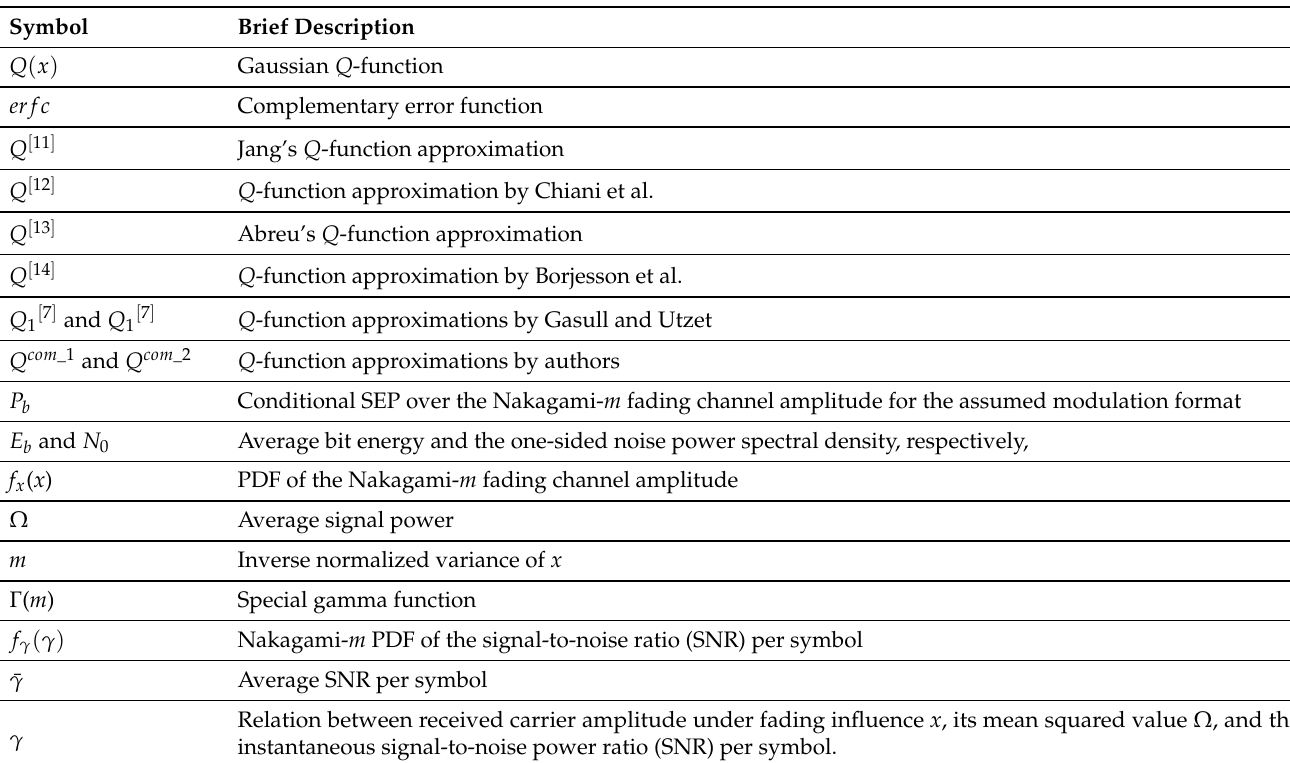
Table 1. Table of important symbols used throughout the paper, in order of